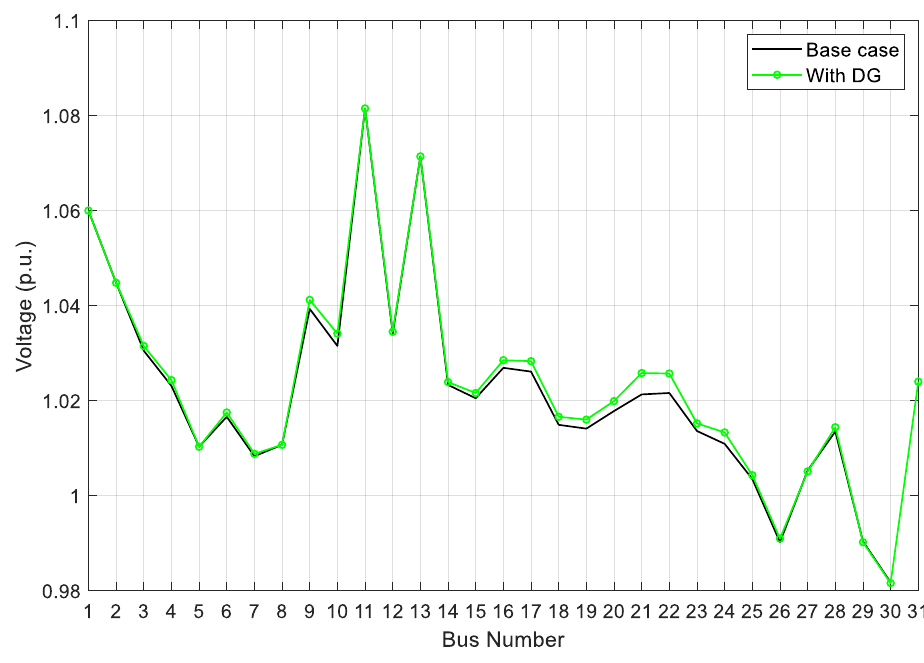
Figure 7. Case II: Voltage profile with/without DG.